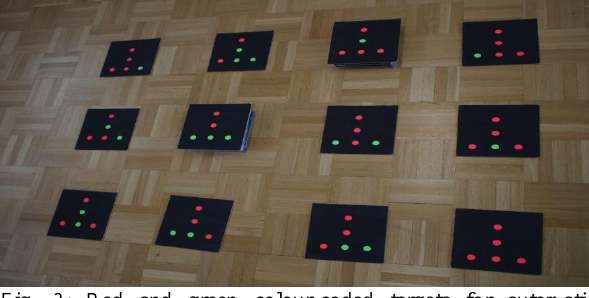
Fig. 3: Red and green colour-coded targets for automatic measurements using the iWitness camera calibration for estimation of the interior orientation parameters.